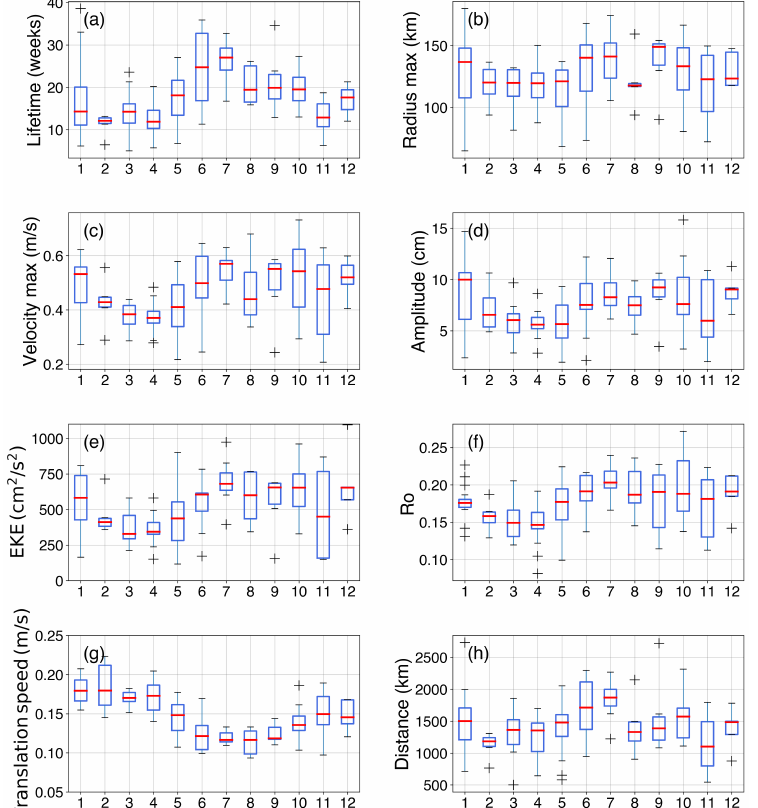
Figure 12. Seasonal cycles of the NBC rings physical parameters during the 27 years of ADT fields. ( a ) Lifetime, ( b ) Radius max ( c ) Velocity max, ( d ) Rossby number, ( e ) Kinetic energy, ( f ) Amplitude, ( g ) Translation speed, ( h ) Distance covered. The box extends from the first to third quartile values, with a red line at the median. The whiskers extend from the edges of the box to show the extreme data points, and black crosses are